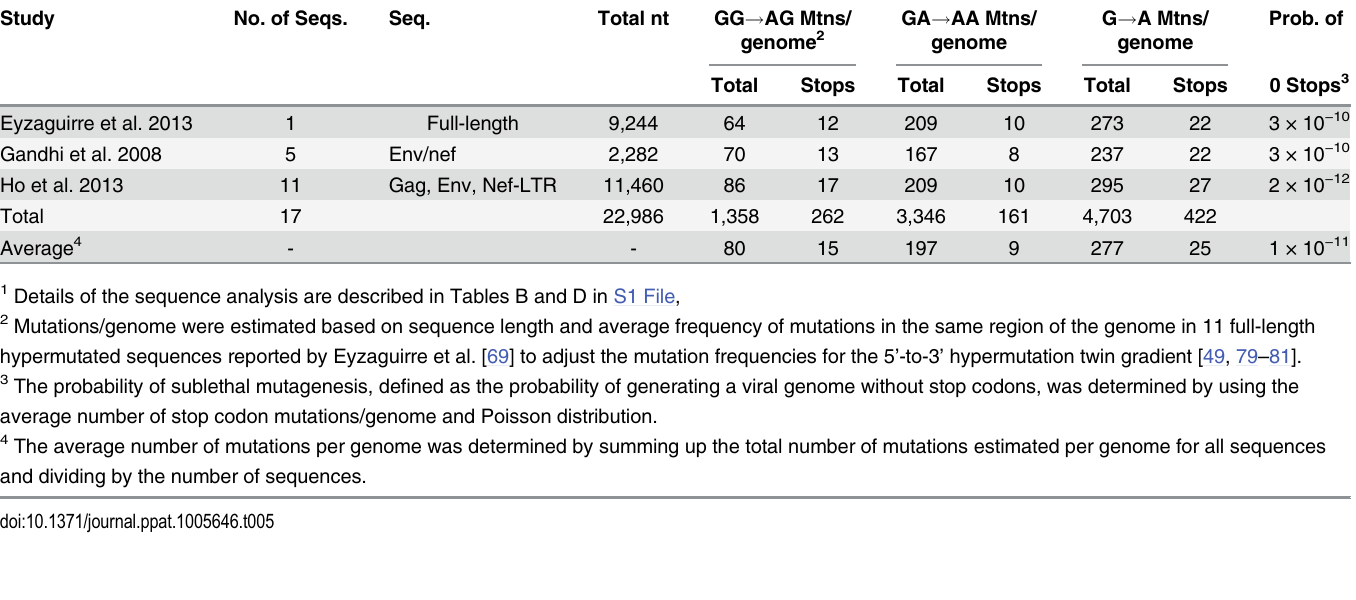
Table 5. Summary of analysis to determine sublethal mutagenesis probability for patient sequences predominantly hypermutated at GA sites 1 . Study No. of